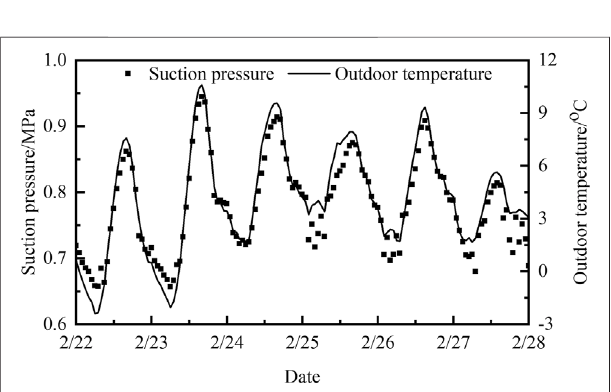
FIGURE 7 | Hourly suction pressure during the test period.